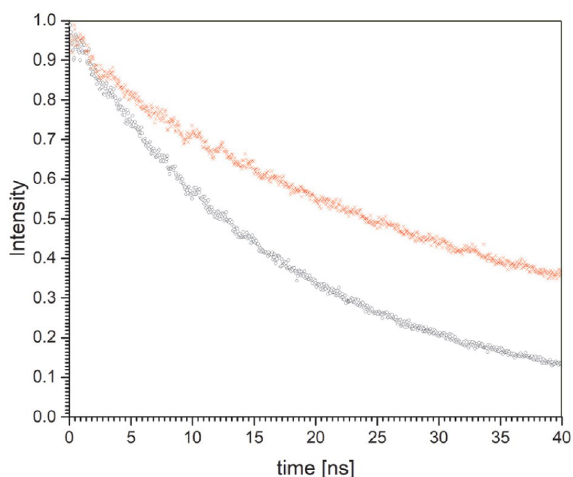
Figure 6. Lifetime measurement of 2 (bottom trace) and 3 (upper